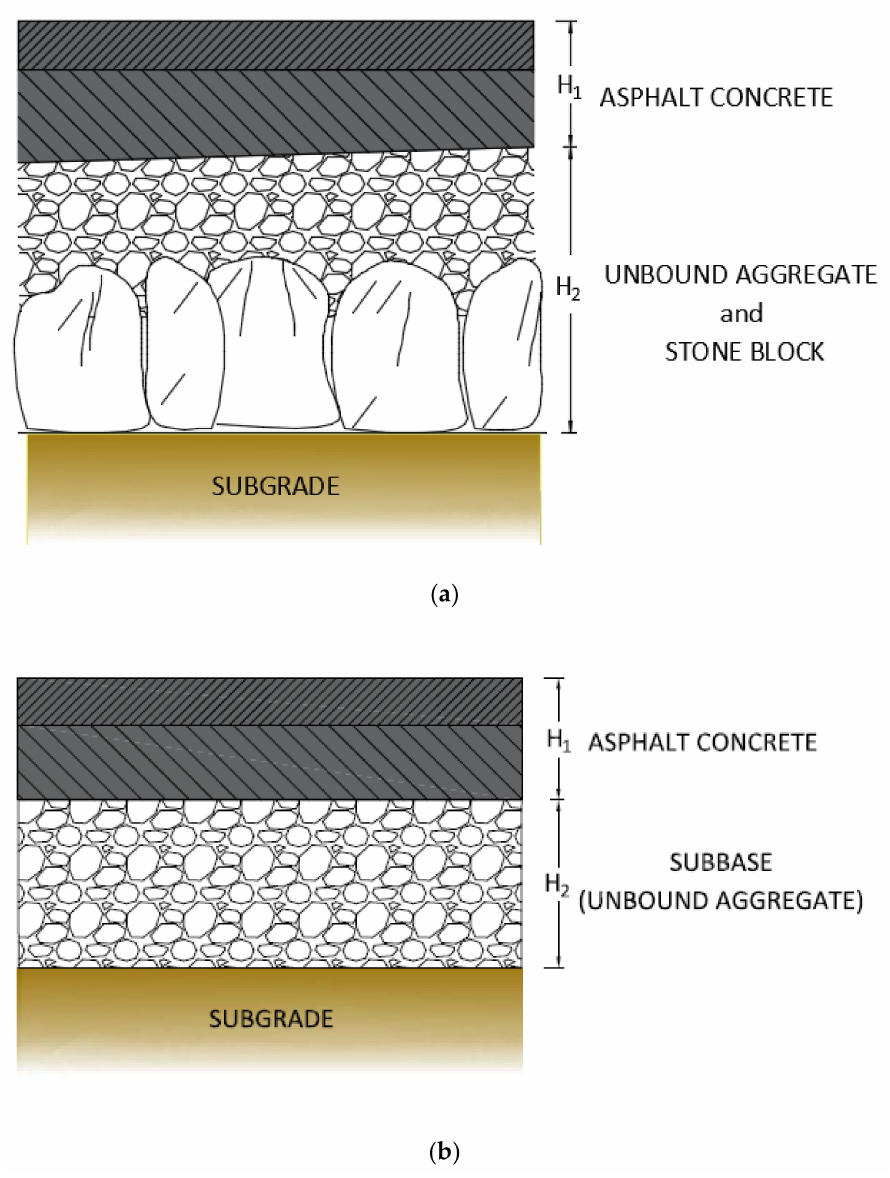
Figure 4. Pavement multilayer scheme ( a ) rural (test site 1 and test site 2). ( b ) Urban (test site